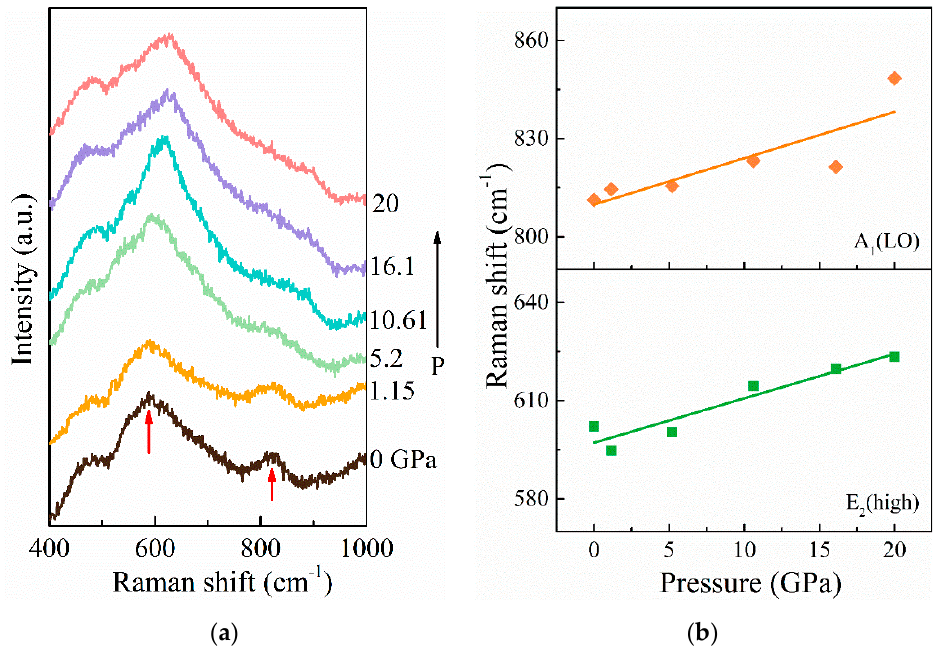
Figure 7. ( a ) Pressure evolution of Raman spectra of the Sc 0.29 Al 0.71 N thin film for pressurization cycle; ( b ) pressure dependence of E 2 (high) and A 1 (LO) phonon modes.